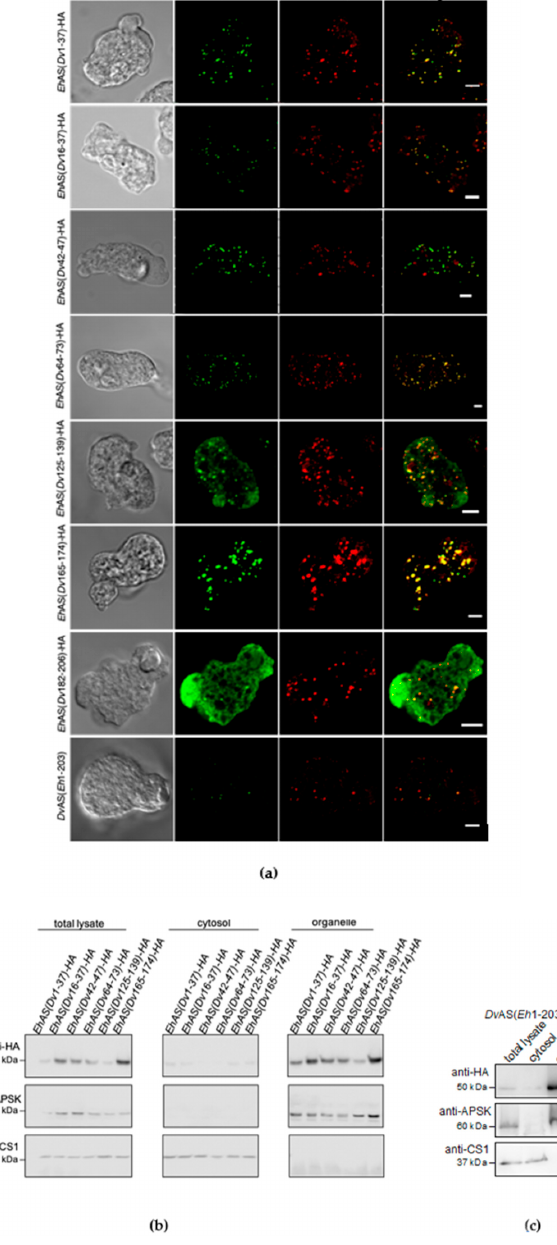
Figure 3. ( a ) Representative immunofluorescence assay micrographs of chimeric Eh AS( Dv 1–37)-HA, Eh AS( Dv 16–37)-HA, Eh AS( Dv 42–47)-HA, Eh AS( Dv 64–73)-HA, Eh AS( Dv 125–139)-HA, Eh AS( Dv 165–174)-HA, Eh AS( Dv 182–206)-HA, and Dv AS( Eh 1–203)-HA expressed in E. histolytica trophozoites, double stained with anti-HA antibody (green) and anti-APSK antiserum (red), respectively. Scale bar, 5 µ m; ( b ) Immunoblotting profiles of the total lysate, cytosol, and organelle fractions of Eh AS( Dv 1–37)-HA, Eh AS( Dv 16–37)-HA, Eh AS( Dv 42–47)-HA, Eh AS( Dv 64–73)-HA, Eh AS( Dv 125–139)-HA, Eh AS( Dv 165–174)-HA, and ( c ) Dv AS( Eh 1–203)-HA, respectively. Membranes were stained with anti-HA antibody (top panel), anti-APSK (organelle marker, middle panel), and anti-CS1 antisera (cytosol marker, bottom panel),